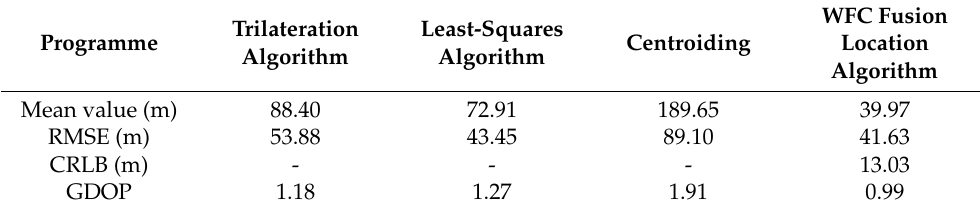
Table 8. Positioning accuracy evaluation index.